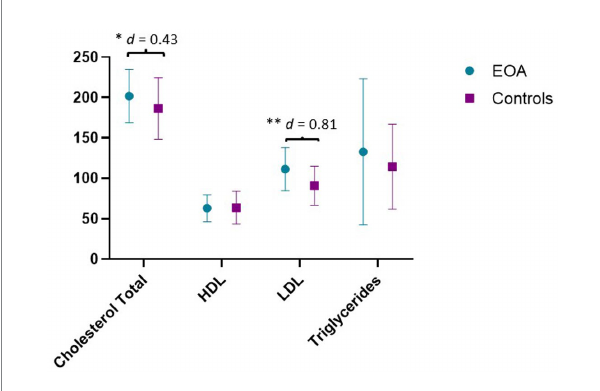
FIGURE 1 Results of serum lipid profile analysis. Results are expressed in ng/ mL. HDL, high-density lipoprotein; LDL, low-density lipoprotein; EOA, Early Osteoarthritis. ** p < 0.01; * p < 0.05; d = Effect